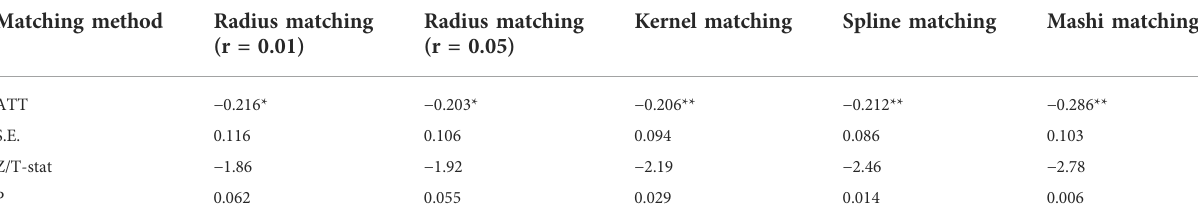
TABLE 4 ATT estimation results (based on psmatch2